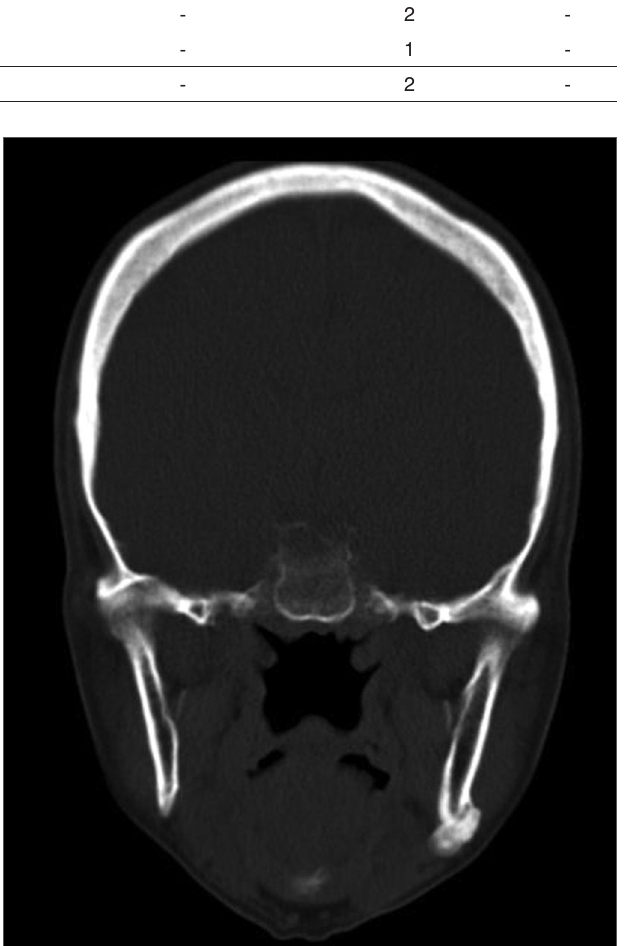
Figura 1. Aspecto pré-operatório: TC em vista coronal mostrando osteoma periférico em ângulo mandibular esquerdo.